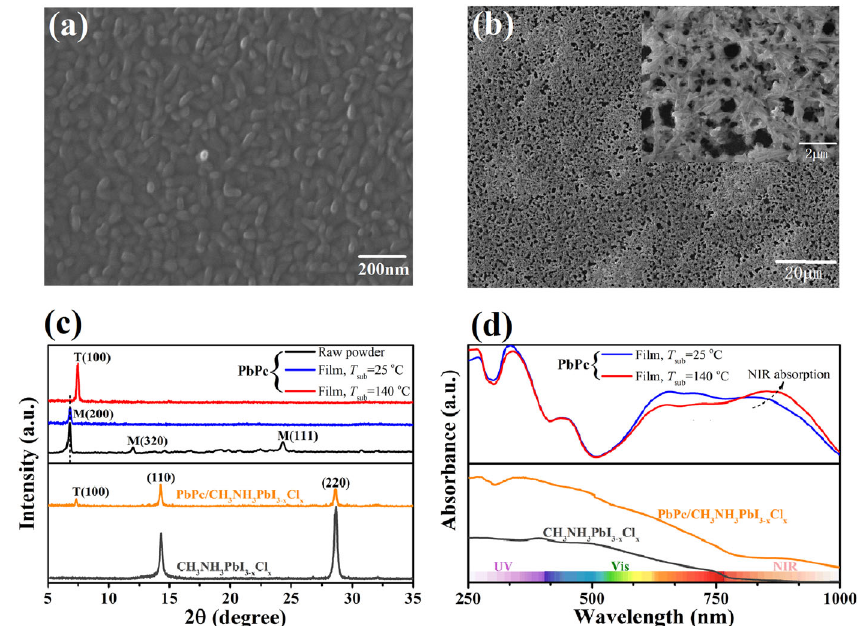
Fig. 2 Properties of organolead perovskite and phthalocyanine. a Representative SEM image of PbPc fi lm evaporated at 140 °C (substrate temperature). b SEM image of MAPbI 3 − x Cl x perovskite fi lm with porous structure. c XRD patterns of the PbPc powder and the 50 nm-thick PbPc fi lms evaporated at 25 and 140 °C (upper half-plane), MAPbI 3 − x Cl x and PbPc/MAPbI 3 − x Cl x thin fi lms (lower half-plane). d Absorption spectra of the 50 nm-thick PbPc fi lms evaporated at 25 and 140 °C (upper half-plane), MAPbI 3 − x Cl x and PbPc/MAPbI 3 − x Cl x thin fi lms (lower